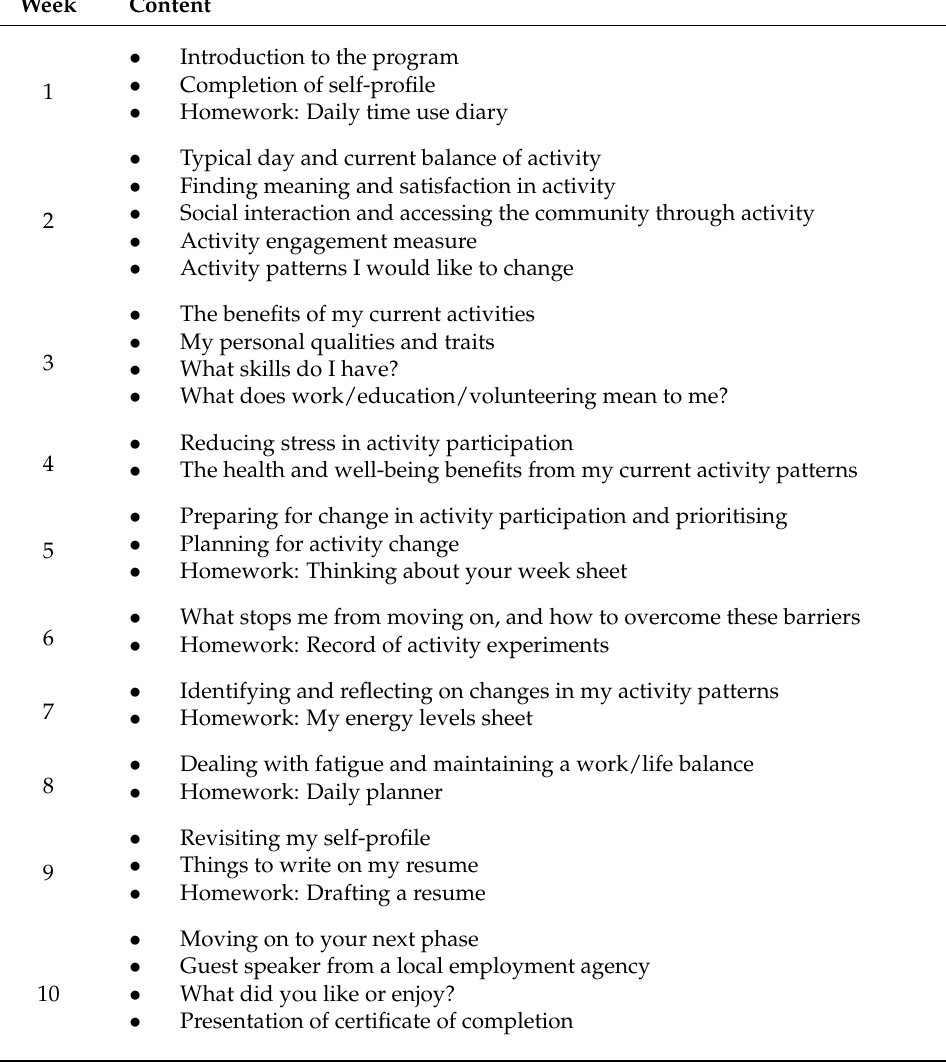
Table 1. Overview of Pathways to Participation (P2P) program